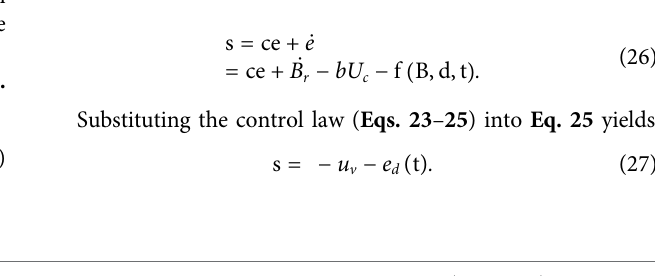
Frontiers in Materials |